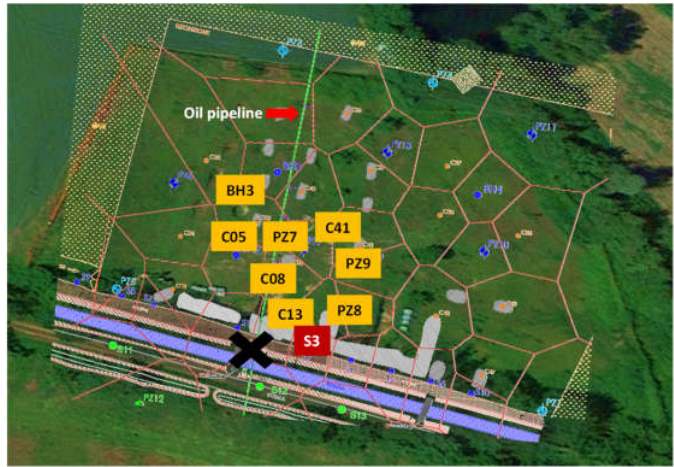
Figure 1. Map of the area under study with the indication of the sampling points, the trace of the oil pipeline and the break-in point (black cross).